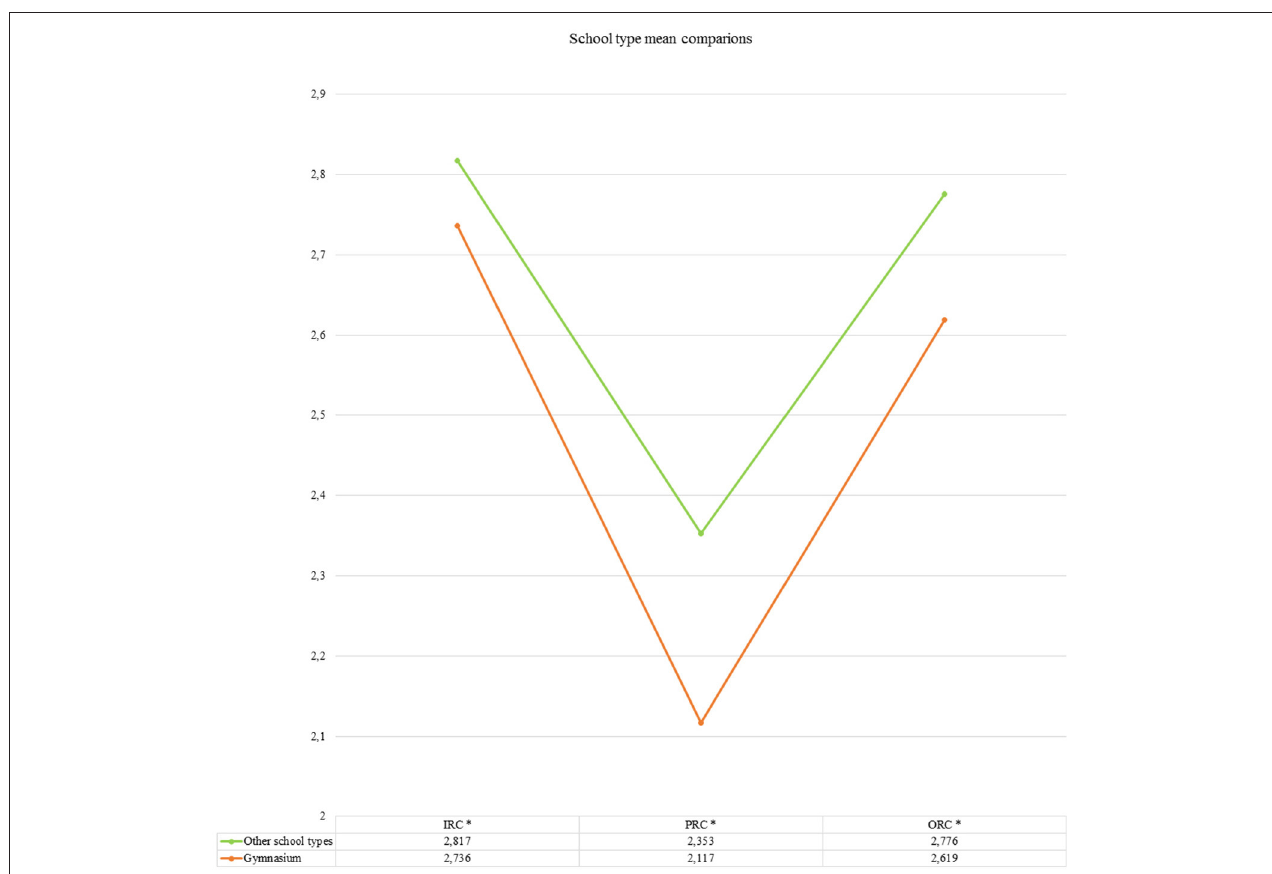
FIGURE 2 | School type mean comparisons. *significant at p < 0.001. Maximum score possible =